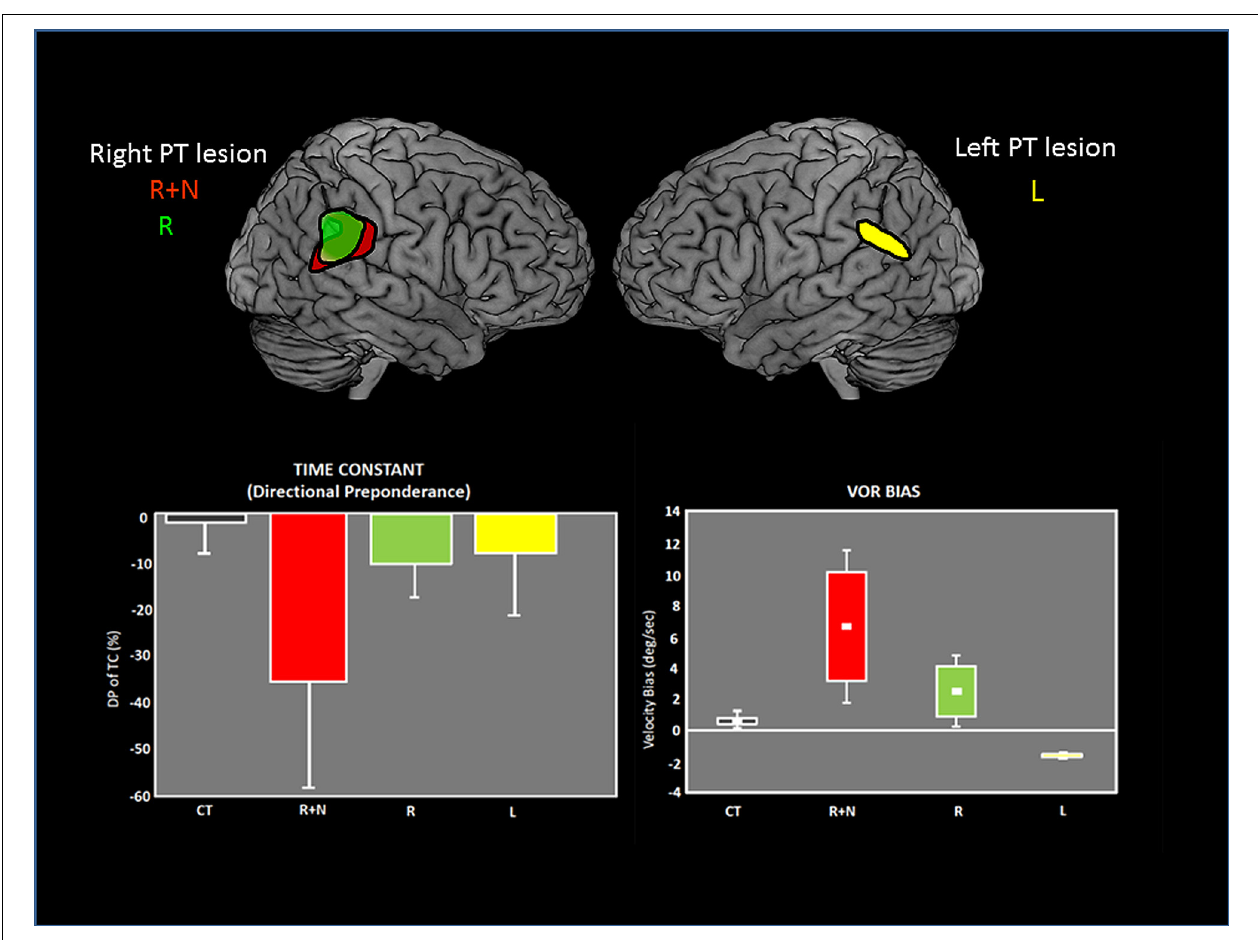
neglect. L: Left lesion. On the bottom, graphs showing the asymmetrical deficits in VOR time constant (measured by the directional preponderance) and the VOR bias in each patient group. The deficits are majored with right lesions with neglect. Adapted from Ventre-Dominey etal.